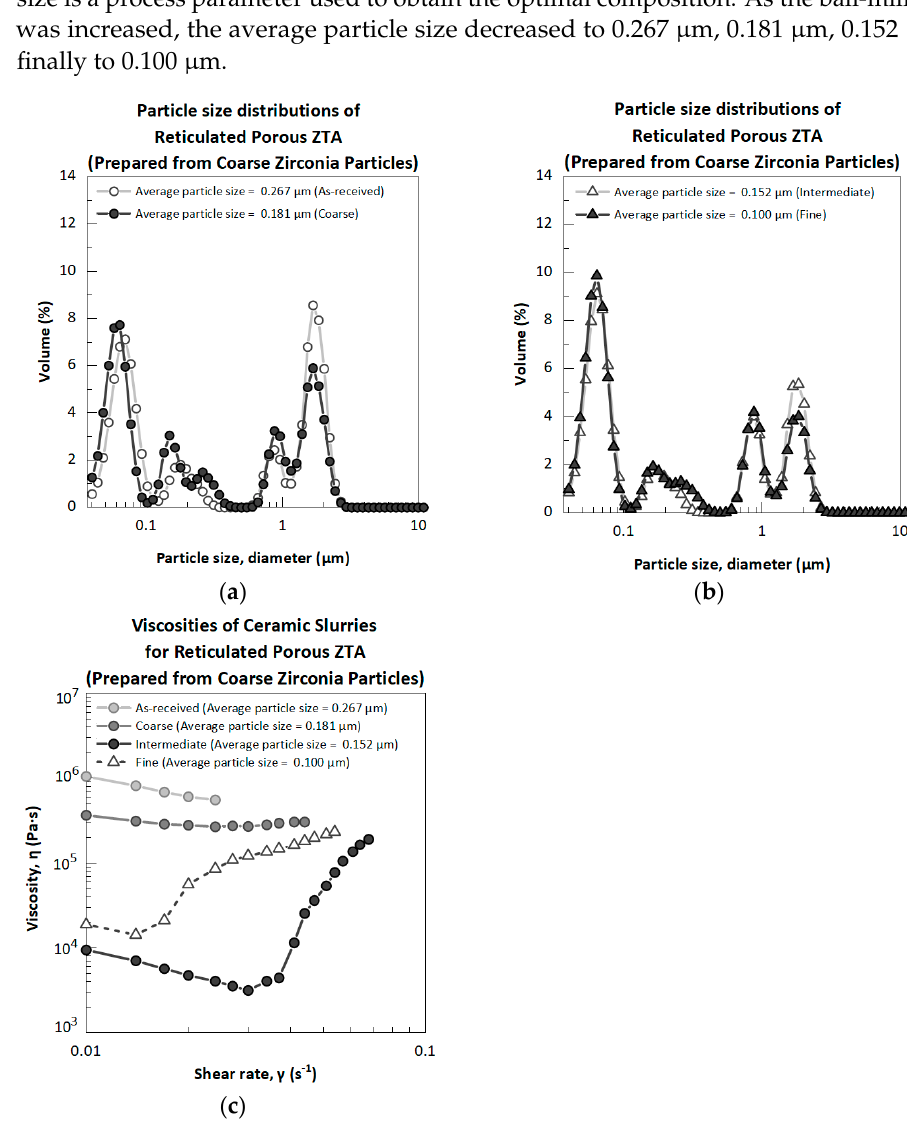
Figure 6. Particle size distributions of ZTA prepared from coarse zirconia: ( a ) as-received and coarse, ( b ) intermediate and fine cases, and ( c ) viscosities of ZTA slurries used to prepare the reticulated porous ZTA: as-received, coarse, intermediate, and fine cases.